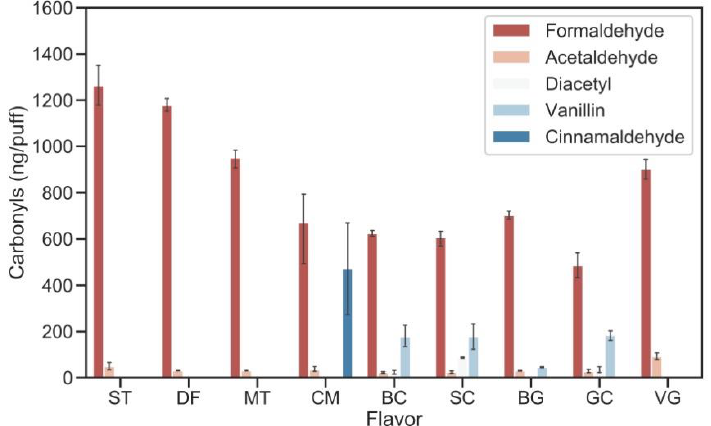
/ pu ff ) generated by di ff erent flavored e-liquids (ST: strawberry, DF: Figure 2. Carbonyl levels (ng/puff) generated by different flavored e-liquids (ST: strawberry, DF: Figure 2. Carbonyl levels (ng